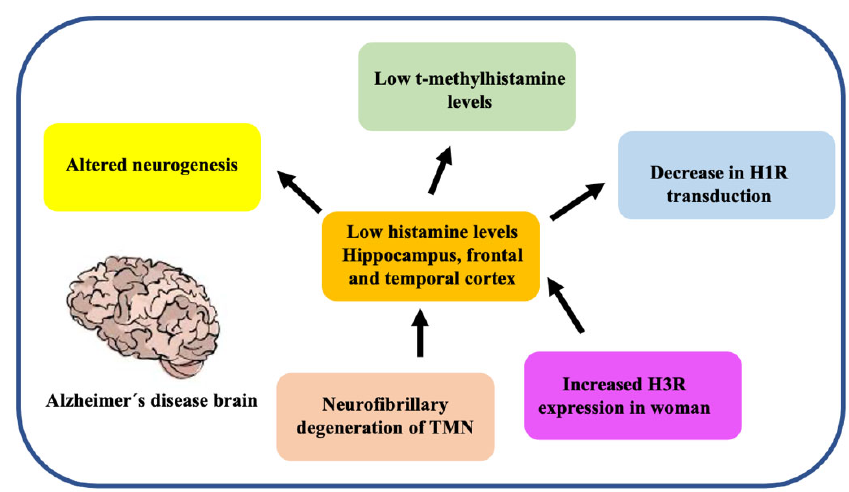
Figure 2. Principal changes in the histaminergic system in the brain of AD patients. AD patients show many alterations related to the histaminergic system such as low brain histamine levels, low H1R expression in both the frontal and temporal cortex, and degeneration induced by neurofibrillary tangles in TMN, the main source of histamine in the